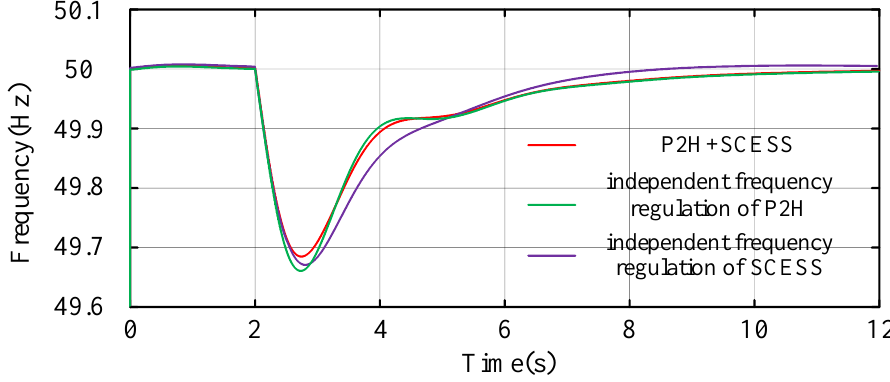
Figure 27. System frequency regulation curve under different strategies.